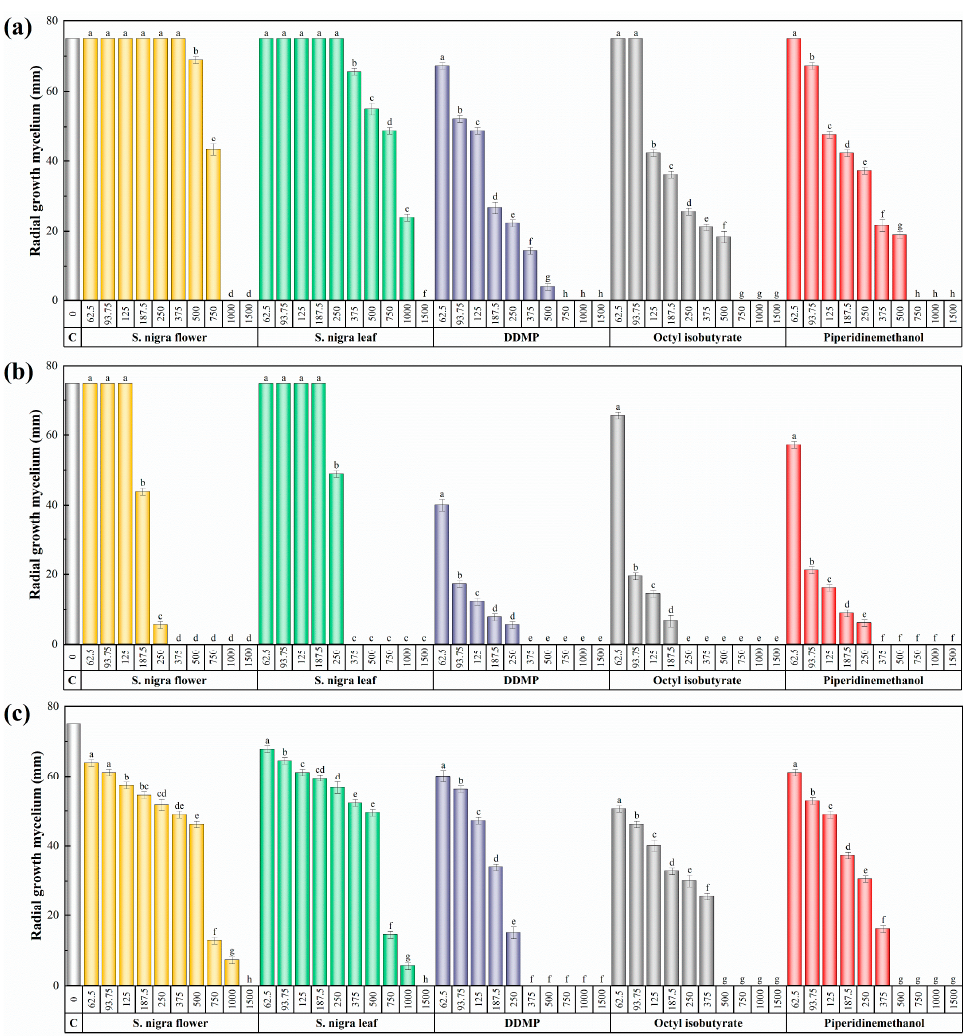
Figure 2. Radial growth of the mycelium of ( a ) D. amygdali , ( b ) P. megasperma , and ( c ) V. dahliae in in vitro assays performed on PDA medium with different concentrations (in the 62.5–1500 μ g·mL − 1 range) of S. nigra flower and leaf extracts, as well as some of the main constituents of flower extract. The same letters above concentrations mean that they are not significantly different at p < 0.05. Standard deviations are represented by error bars. DDMP = 4H-pyran-4-one, 2,3-dihydro-3,5-dihydroxy-6-methyl-; piperidinemethanol = 1-methyl-2-piperidinemethanol.